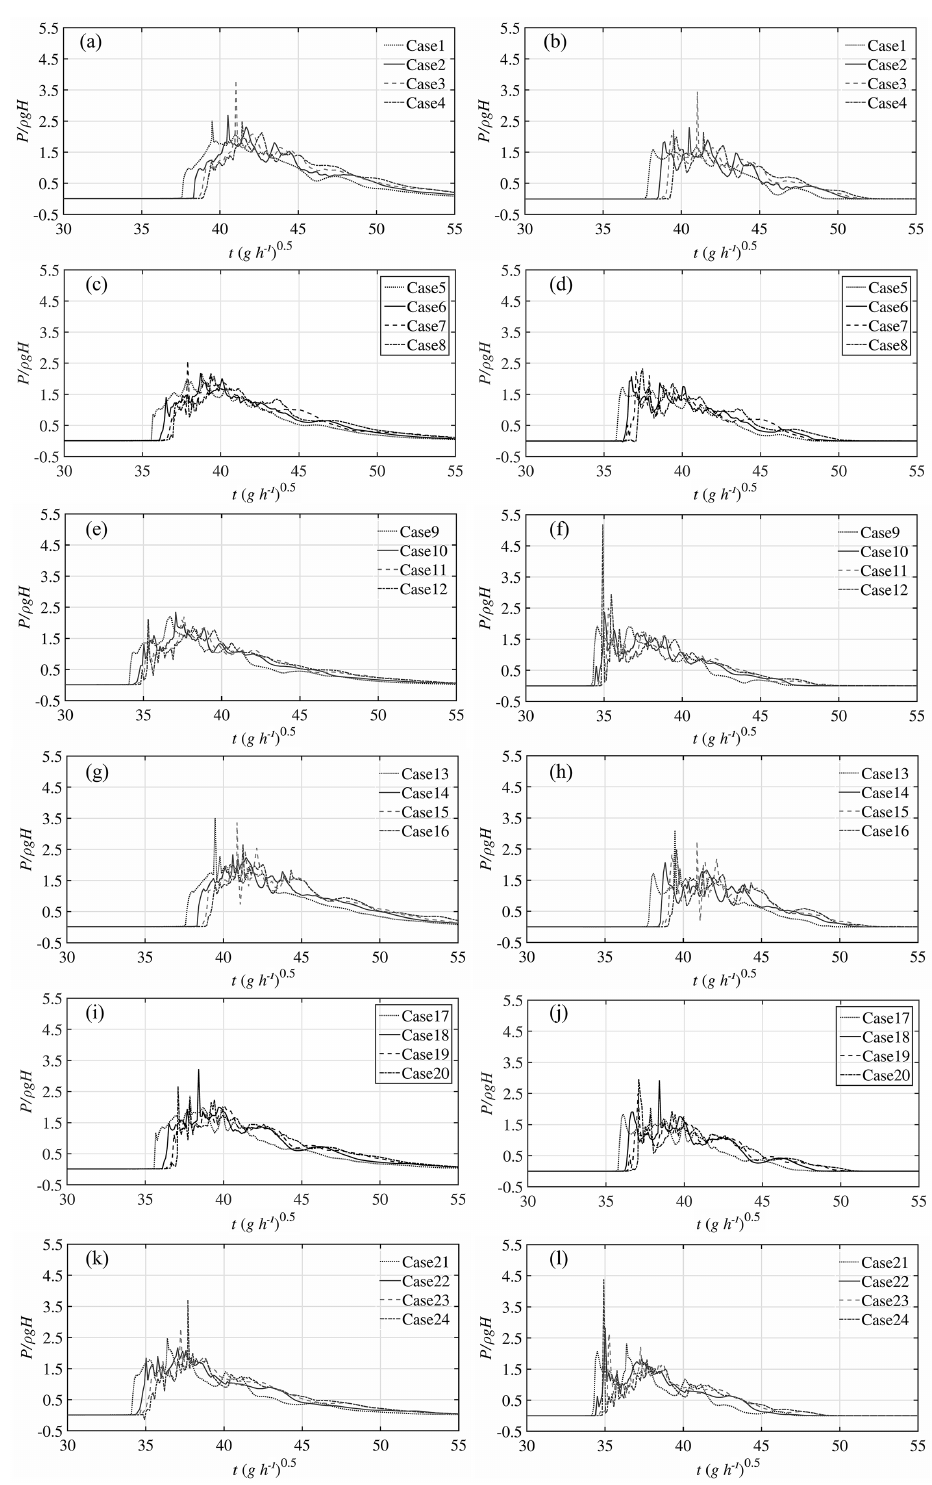
Figure 10. Time histories of impact pressure on the cliff: (a, c, e, g, i, k) P3; (b, d, f, h, j, l)